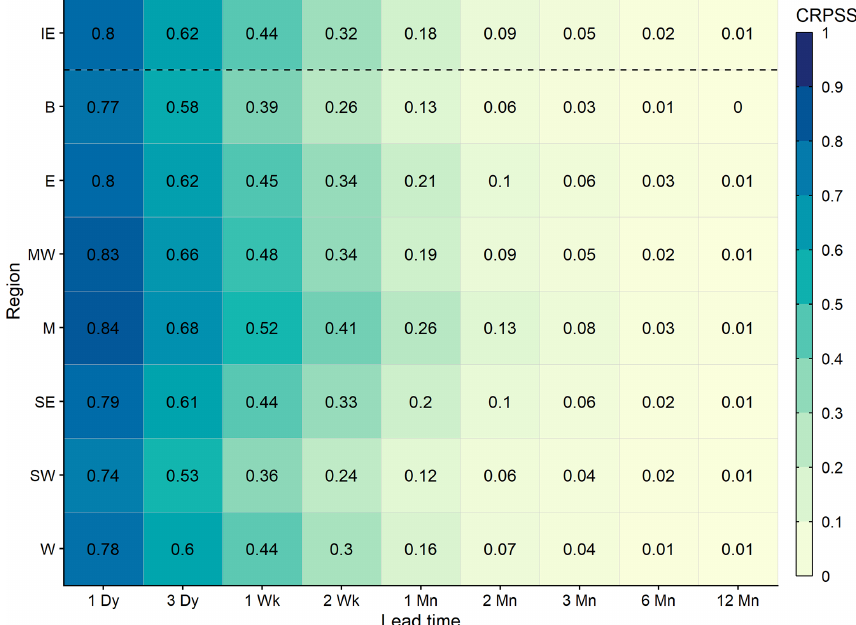
Figure 5. CRPSS values for Ireland (IE) and seven NUTS III regions (B, E, MW, M, SE, SW, and W) averaged across all initialisation months for a selection of lead times: short (1 and 3d), extended (1- and 2-week), monthly (1- and 2-month), seasonal (3- and 6-month) and annual